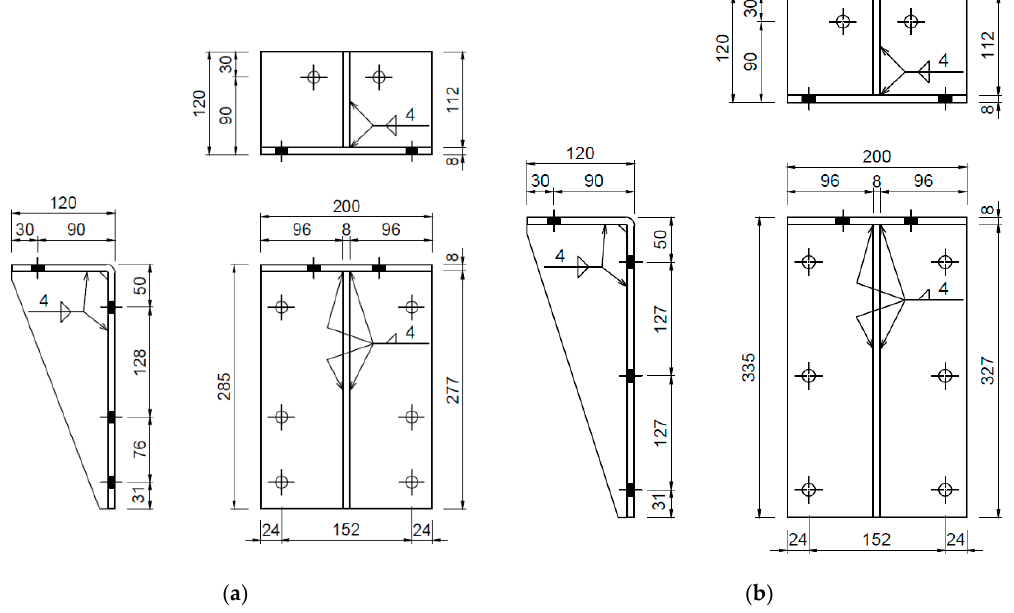
Figure 5. Dimensions of the reinforcement clip ( a ) for Z300 and ( b ) for Z350 (mm).